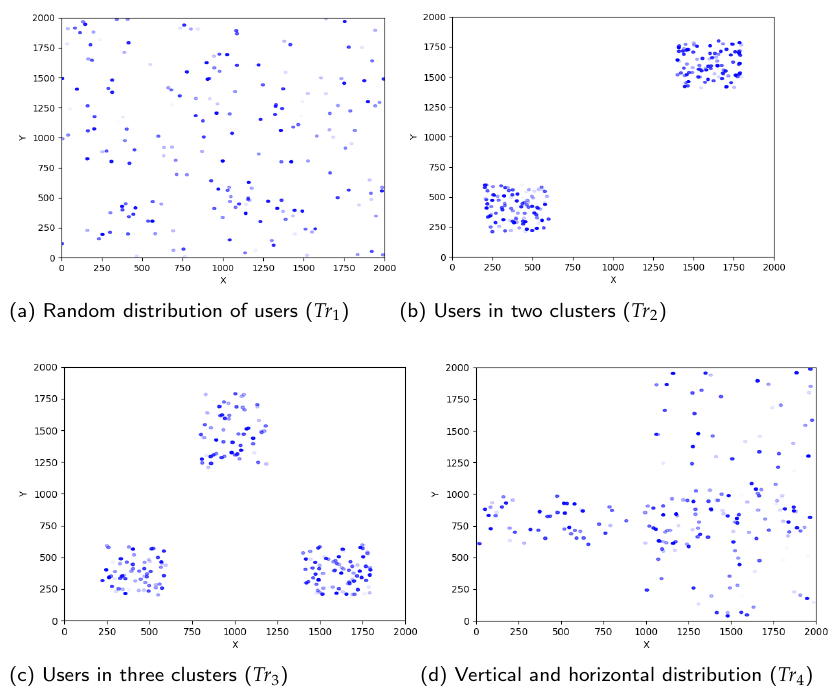
Figure 1. Four training scenarios, where blue dots show the location of users. Lighter color represents low-bandwidth-demanding users and darker color shows higher bandwidth demand.